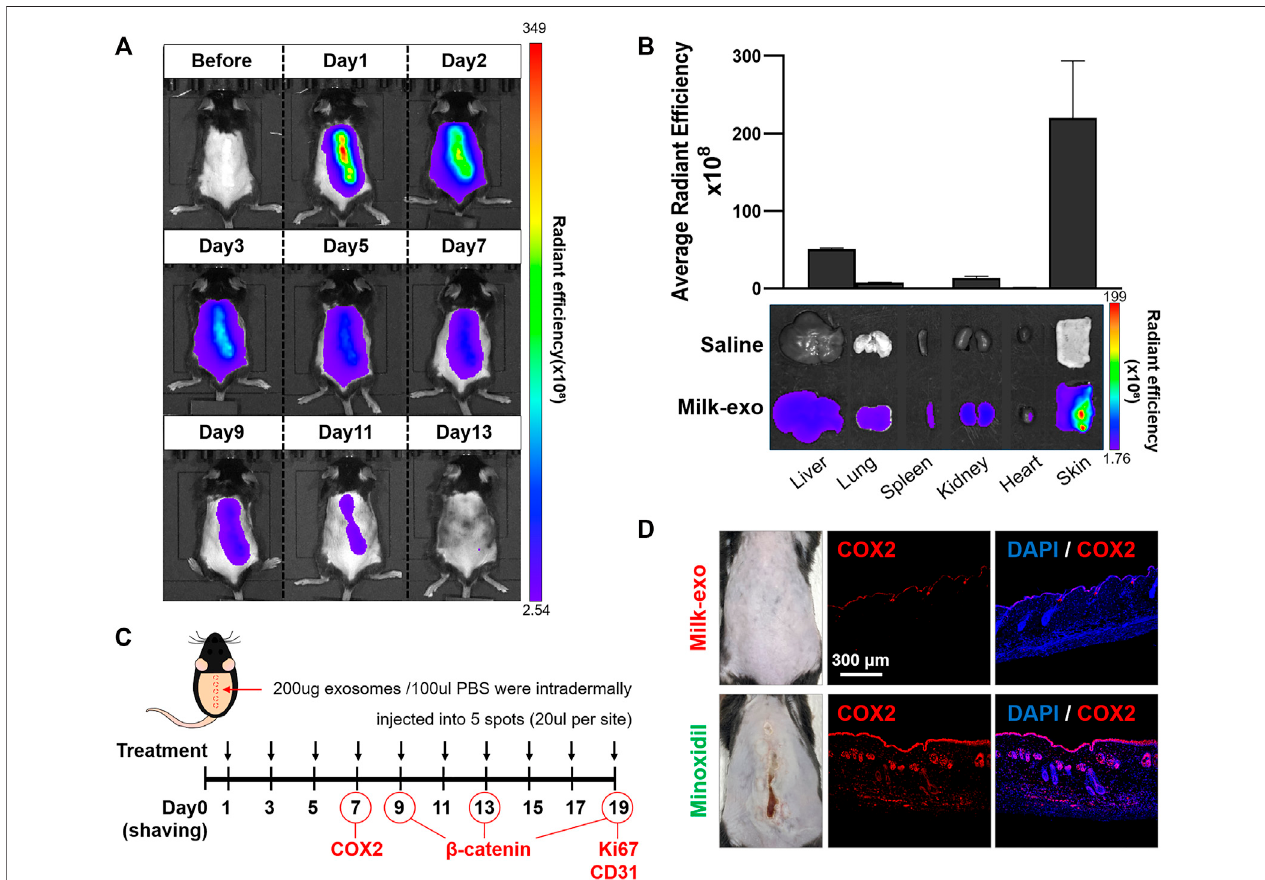
FIGURE4| Invivo biodistributionofMilk-exoandexpressionofCOX2inskintissue. (A) Real-time invivo imagingofCy5.5-NHSlabeledexosomeinC57BL/6mice for 13 days after intradermal injection. The mice were analyzed at the indicated times after intradermal injection of 200 µg per 100 µL of exosomes. (B) Ex vivo imaging and Milk-exo quanti fi cation of the skin and major organs on day 2 after intradermal injection of labeled exosomes ( n = 3). (C) Schedule of Milk-exo treatment (black arrows) and thedate ofhistological analysis(COX2, β -catenin,Ki67and CD31). (D) Representativeimmunostaining images ofthe expression ofCOX2 inmice skin tissuestreatedwithMilk-exoandMinoxidil.C57BL/6miceweresacri fi cedonday7afterintradermalinjectionevery2 days.Thenuclei(blue)werestainedwithDAPI,and Alexa Fluor ® 647 conjugated secondary antibodies (red) were used for visualization of COX2.